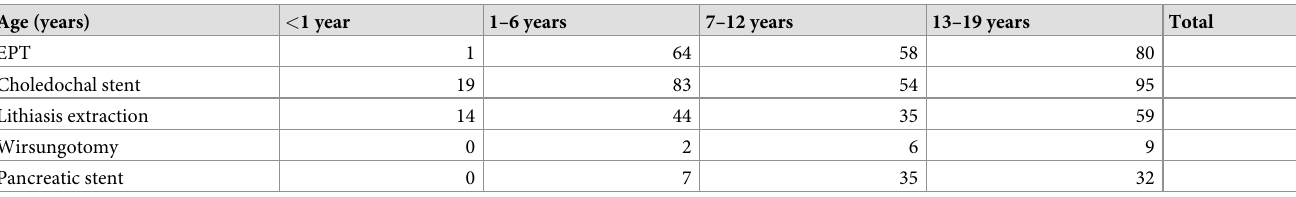
Table 4. Endoscopic therapeutic procedures stratified by age—Absolute